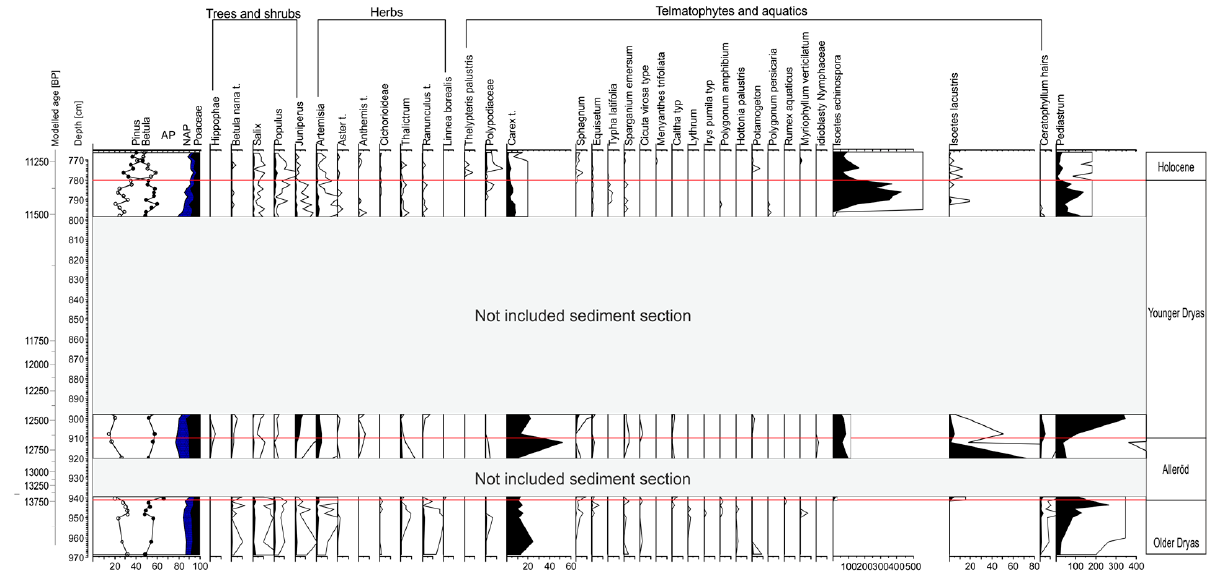
Figure 7. Percentage pollen diagram determined for selected sediment sections of Z ‐ 3 core.